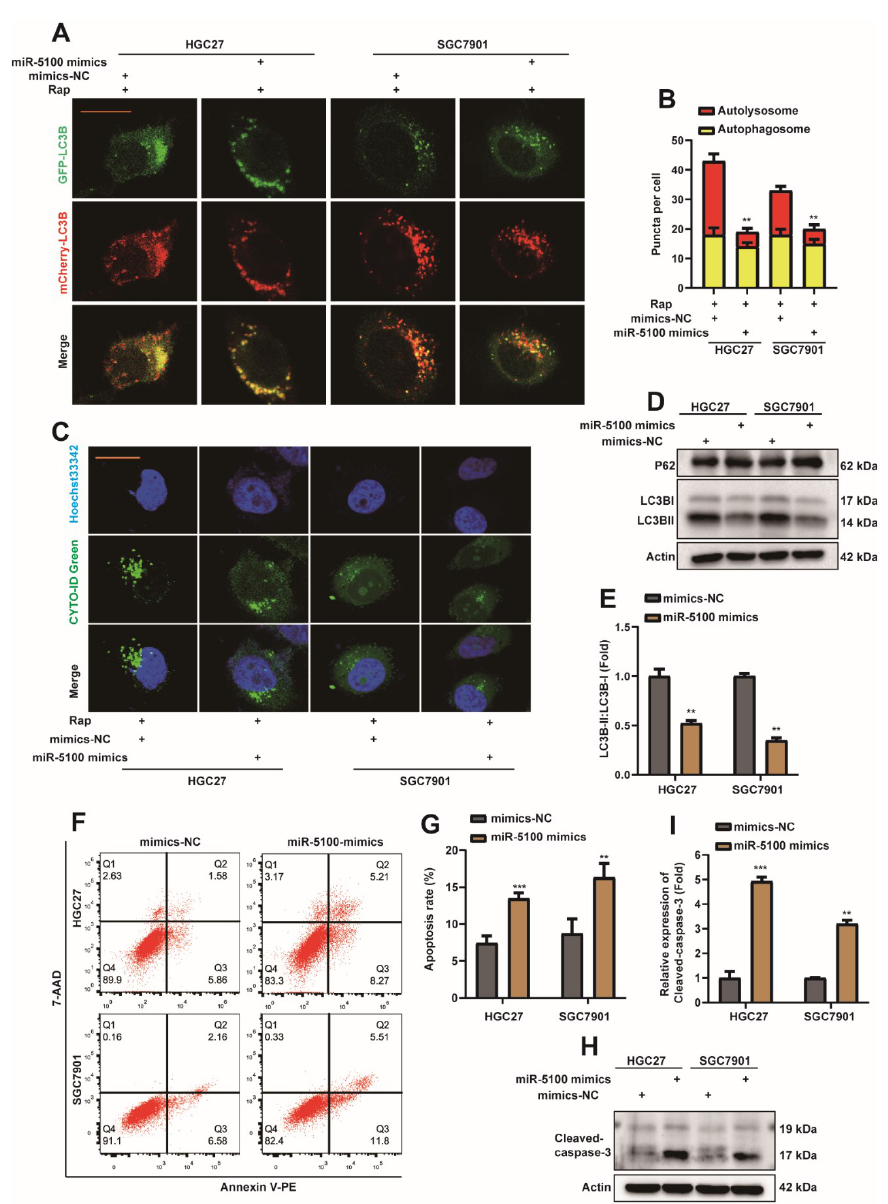
Figure 5. miR-5100 inhibits autophagy and promotes apoptosis in GC cells. ( A ) miR-5100 mimics/mimics-NC were transfected into HGC27 or SGC7901 cell lines stably expressing mCherry- EGFP-LC3B. Cells were treated with 5 nM rapamycin (Rap) 24 h after transfection, and autophagic flux was observed 8 h later. (scar bar = 40 μm). ( B ) Autophagosome (red dots) and Autolysosome (yellow dots) were counted and analyzed, **: p < 0.01. ( C ) miR-5100 mimics/mimics-NCs were trans- fected into HGC27 or SGC7901 cell lines. Cells were treated with 5 nM rapamycin (Rap) 24 h after transfection, and the level of autophagy was observed 8 h later. ( D , E ) miR-5100 mimics/mimics-NCs were transfected into HGC27 or SGC7901 cell lines, and cells were harvested 36 h later. Western Blot detection of DEK, p62, LC3B proteins. The ratio of LC3BII/I was analyzed by normalization with Actin ( n = 3, **: p < 0.01). ( F , G ) miR-5100 mimics/mimics-NC were transfected into HGC27 or SGC7901 cell lines, and the apoptosis rate was analyzed by flow cytometry after 36 h, and statistical analysis was performed ( n = 3, **: p < 0.01, ***: p <0.001). ( H , I ) miR-5100 mimics/mimics-NC was transfected into HGC27 or SGC7901 cell lines, and 36 h later, the expression of Cleaved-caspase-3 was detected by Western Blot, and quantitative analysis was performed ( n = 3, **: p < 0.01, ***: p